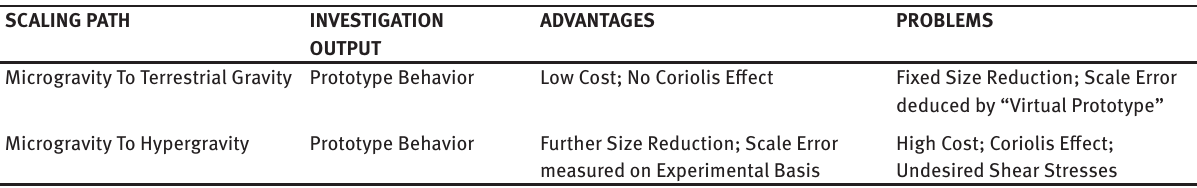
Table 1: Scaling strategies for simulating the behavior of a lunar structure. SCALING